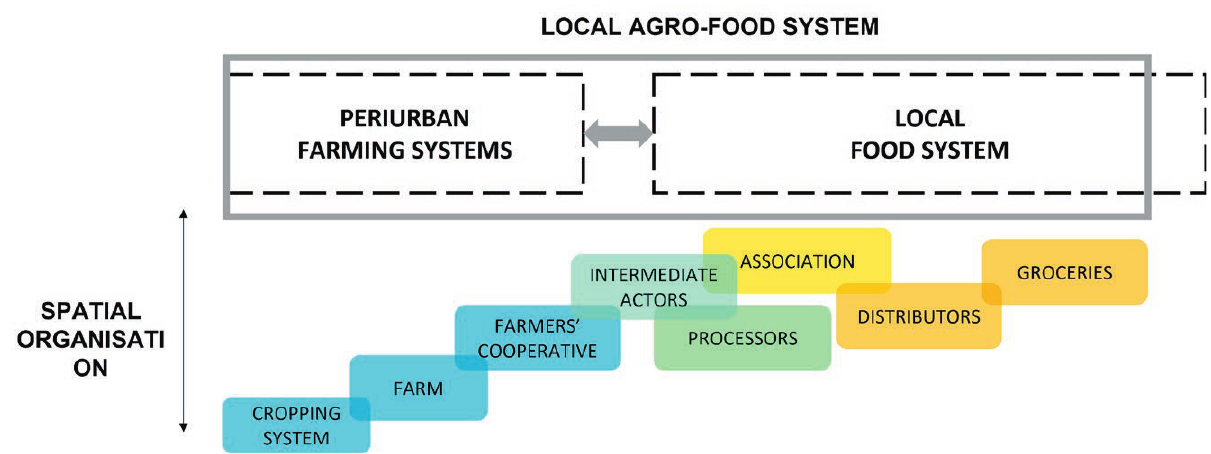
Figure 2. Multi-level and multi-actor approach: elements of the local agro-food